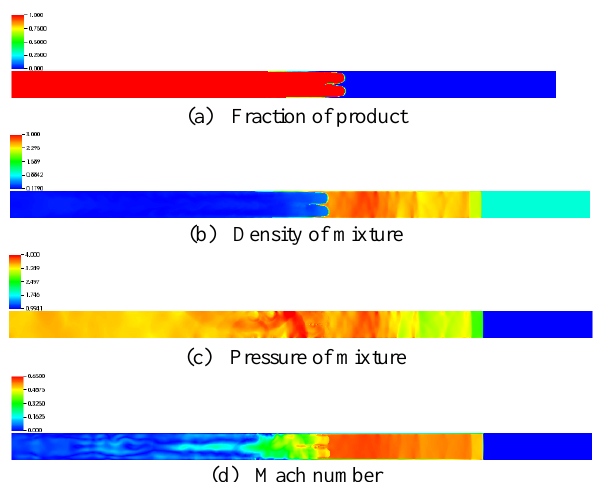
Figure 2 Distributions of physical quantities of a fast deflagration after the ignition by a line source on the end wall, in which the density in (b) and pressure (c) are normalized by the initial density and pressure, respectively